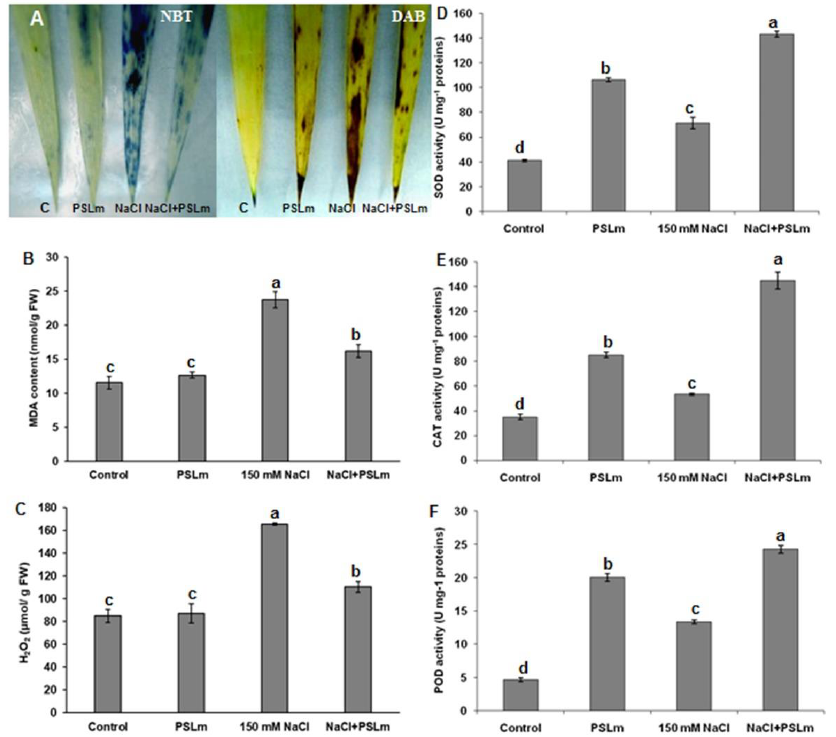
Figure 3. O 2 − localization by NBT staining (upregulated) and H 2 O 2 localization by DAB staining (downregulated) ( A ), ( B ) MDA content, ( C ) H 2 O 2 content, ( D ) SOD activity, ( E ) CAT activity, and